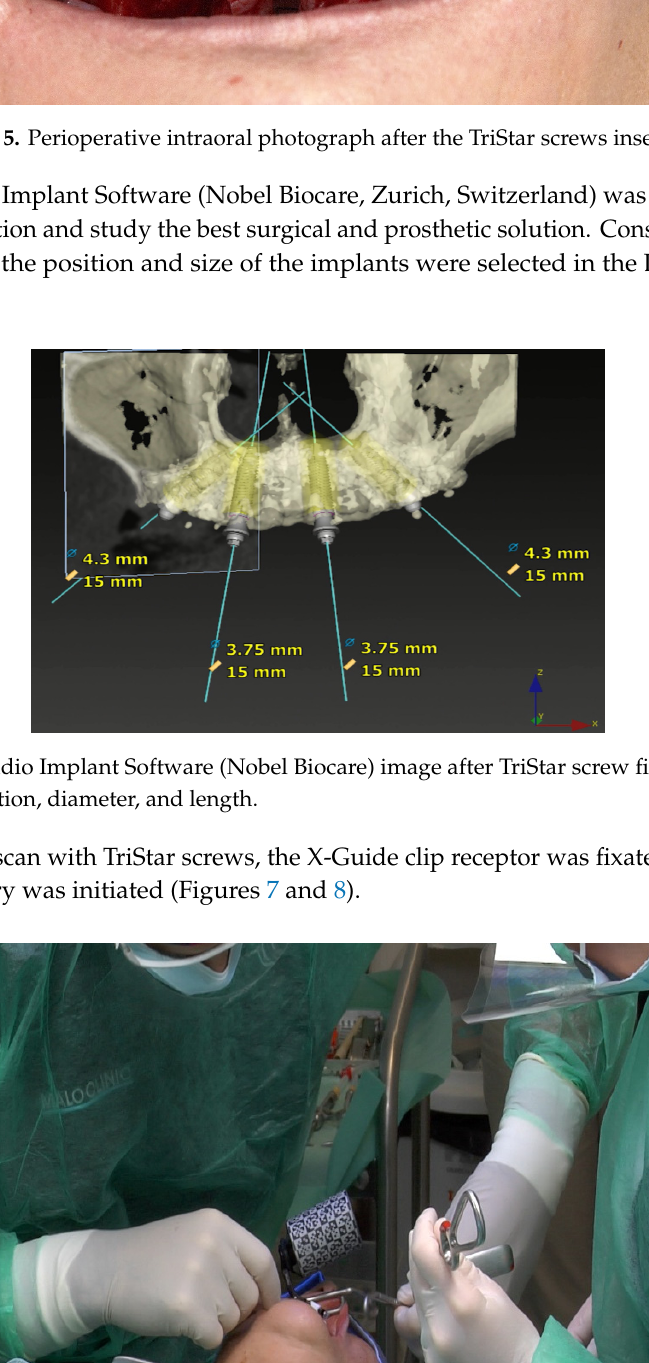
Figure 8. X-Guide clip receptor in place on the patient’s mouth and attached to the extra-oral array. The surgical staff followed the prompts in the X-Guide software (X-Nav Technologies, LLC, Lansdale, PA, USA). Instruments and edentulous fiducial markers calibration (handpiece tracker, chuck, probe tool, 5 TriStar, and the preparation drills) (Figure 9) was as follows: the overhead blue lights were reflected by the arrays of the clip receptor, which contained fiducial markers, and read by two cameras, providing the instruments’ tridimensional position and displayed in the navigation system. The handpiece also holds an array that, when combined with the fiducial markers on the clip receptor, provided accurate navigation through triangulation. Care had to be taken to ensure that the remaining instruments were in the cameras’ field of vision to be precisely tracked on the monitor.